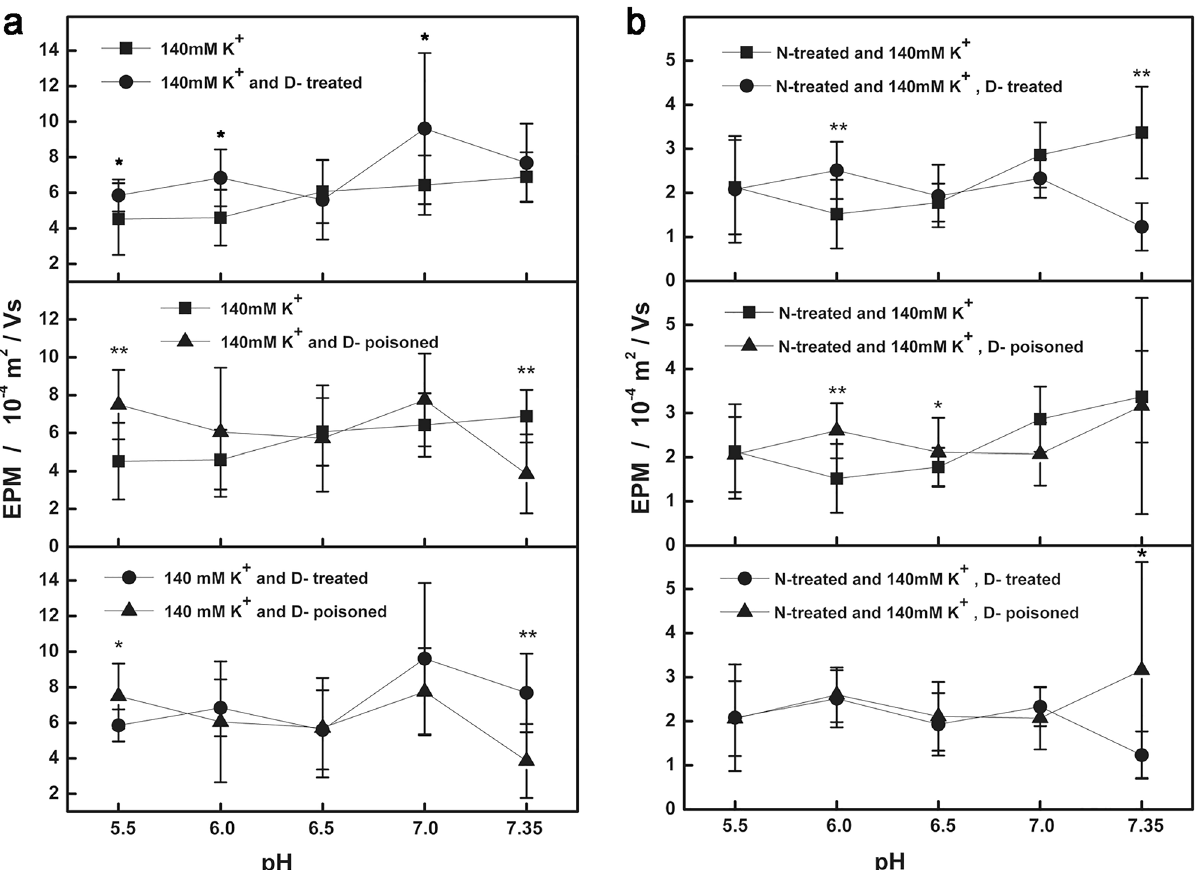
Figure 2. After decomposition of surface potential impact of digoxin on EMP of cardiomyocyte. ( a ) Three groups EPM of cardiomyocytes measured in the suspensions of 140 mM KCl (transmembrane potential was zero), 10 mM NaCl, 2 mM CaCl 2 and pH 5.5–7.35. ( b ) After the cardiomyocytes are treated with neuraminidase, three groups EPM measured in the suspensions of 140 mM KCl (transmembrane potential was zero), 10 mM NaCl, 2 mM CaCl 2 and pH 5.5–7.35.